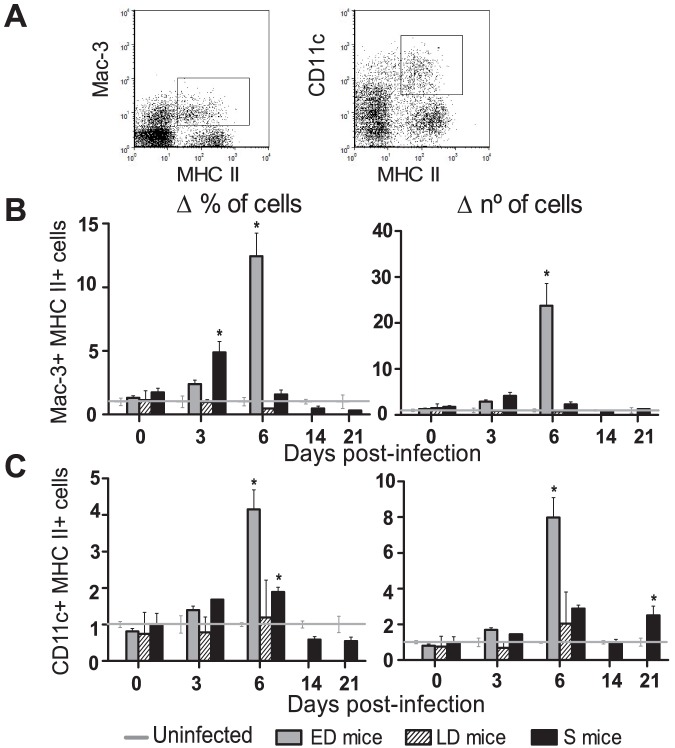
Monocytes and DCs increase in blood of ED mice during acute infection.WBCs were isolated from the PB during the 1st
PyL infection in ICR mice and (A) monocytes (Mac3+ MHC II+) and DCs (CD11c+ MHC II+) were detected by flow cytometry. Animals were classified depending on the infection profiles as early deceased (ED), late deceased (LD) or surviving (S) and (B, C) their cell frequencies with respect to total leukocytes and numbers were recorded. Data express mean ± SEM of 2 independent experiments, each with n>3 mice per time point. The data for each infected mouse was normalized to the data recorded in 5 uninfected mice per experiment. Initial numbers of macrophages were 10.69±2.57×104 and of DCs were 3.80±0.30×105 per ml of blood.*p<0.05 with respect to uninfected mice.